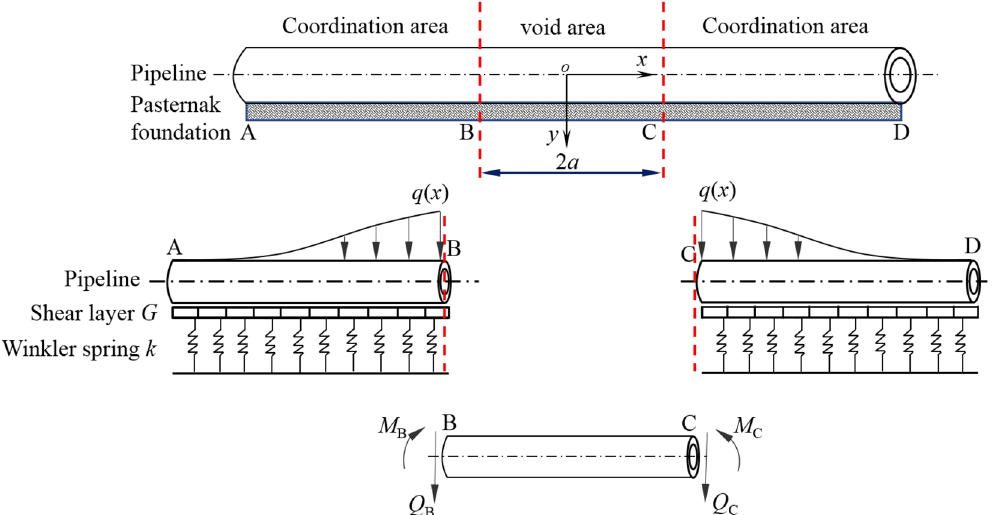
Figure 4. Analysis model of pipe deformation in coordination area and void